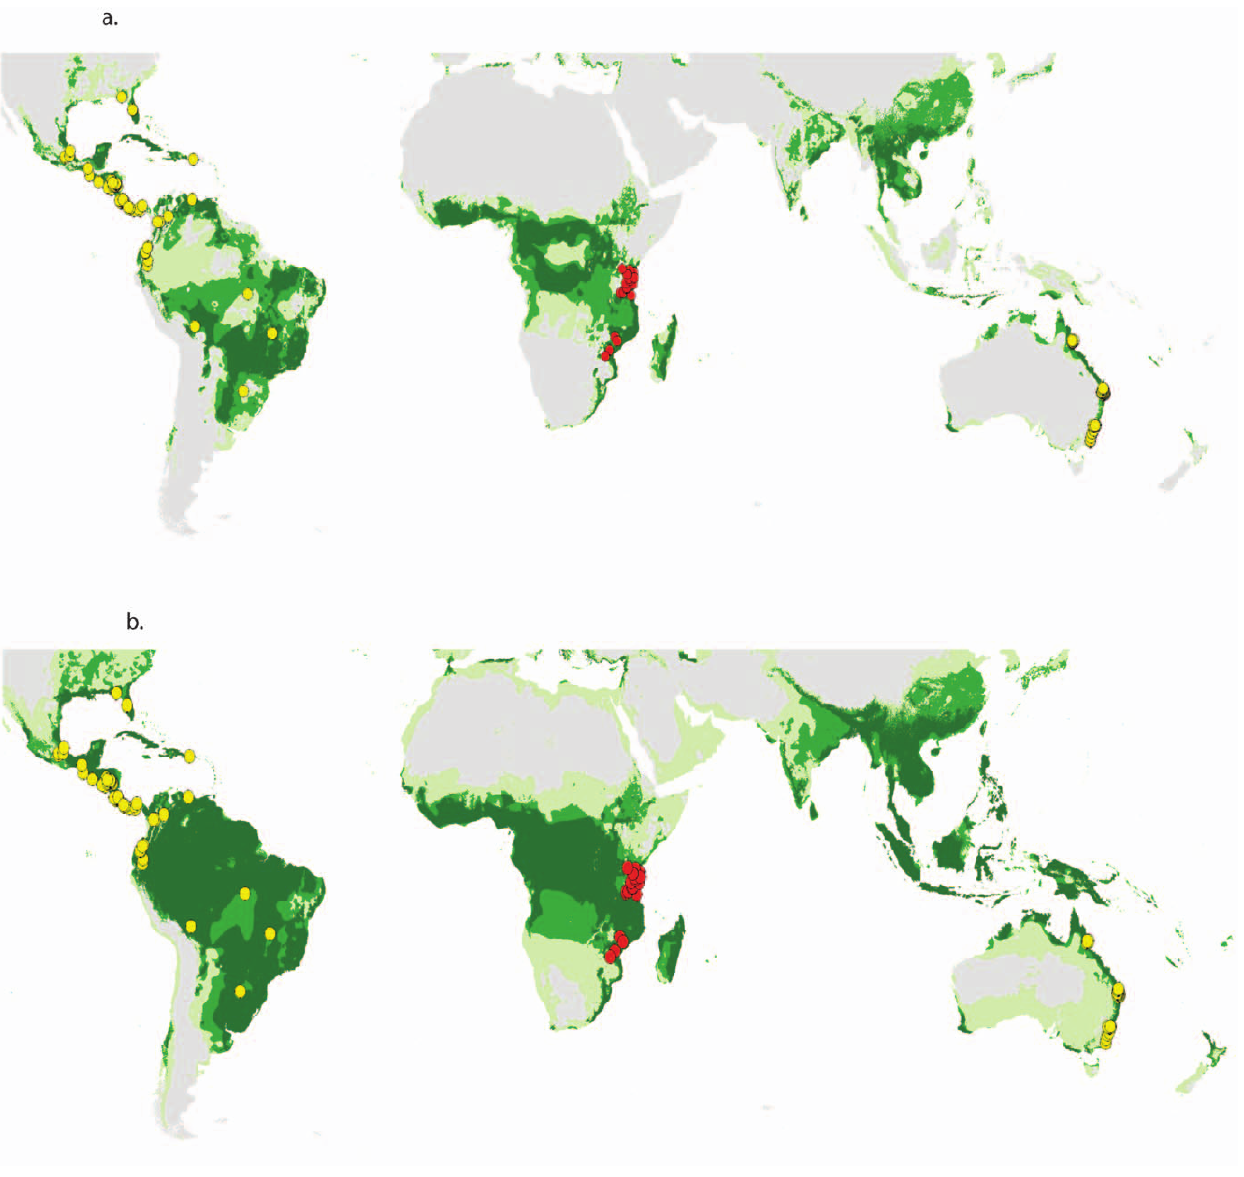
Figure 2. Climate matching for I.walleriana based on the climate of (A) native populations and (B) both native and introduced populations. Green shades indicate land surfaces with five, six and seven climate variables that fall within the native climate space, with darker shades indicating more matching climate variables. Gray indicates land surfaces with four or fewer climate variables in common with the range used to develop the model. Native localities used are shown in red, and the introduced localities in yellow.